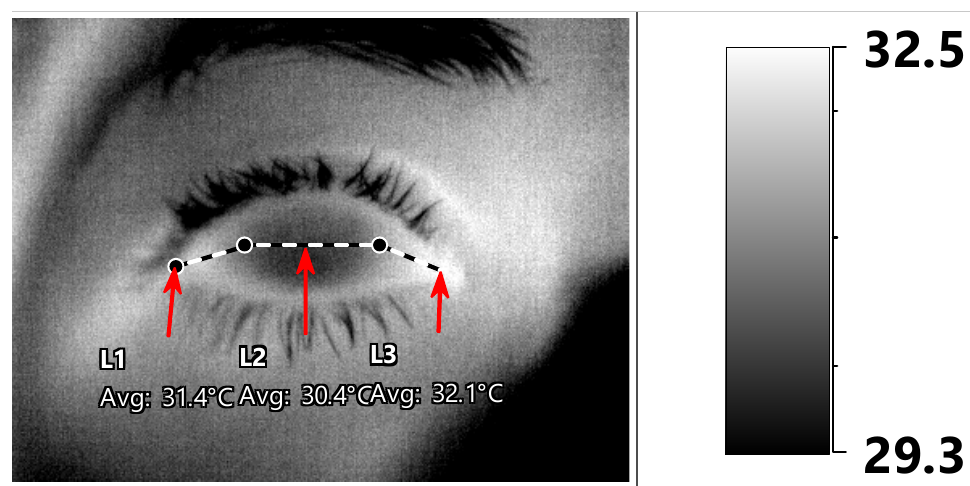
Figure 1. Post-acquisition ocular surface temperature (OST) manual measurements. The mean OST was measured along three horizontal lines (medial cantus -> nasal limbus -> temporal limbus -> lateral cantus) designated as medial canthal, central corneal, and lateral canthal ocular surface regions (L1, L2, and L3, respectively, indicated by red arrows).